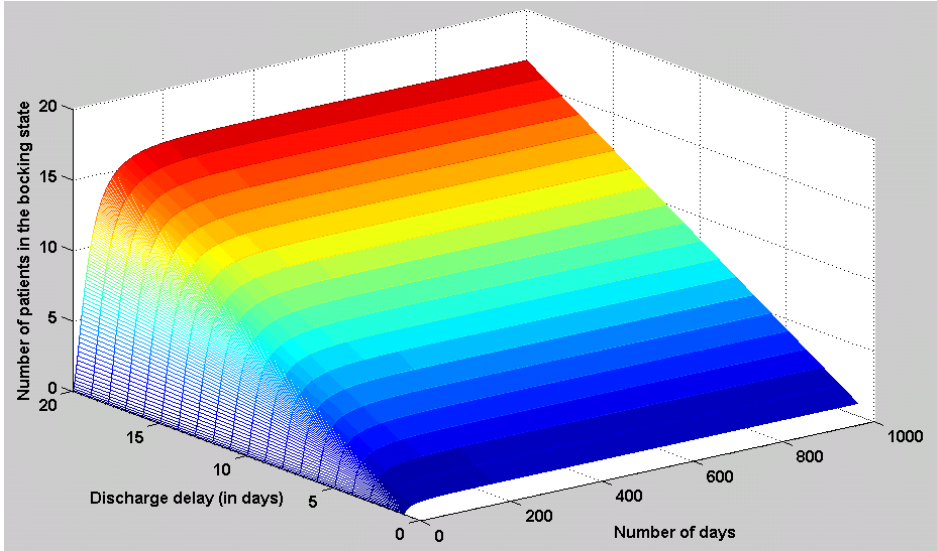
Figure 20. The estimated number of patients (with respect to discharge delay) in the blocking state for discharge to other destinations.